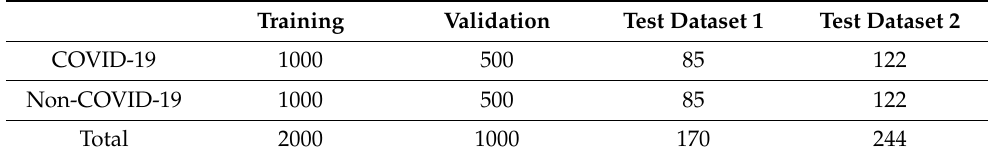
Table 3. Dataset split during model